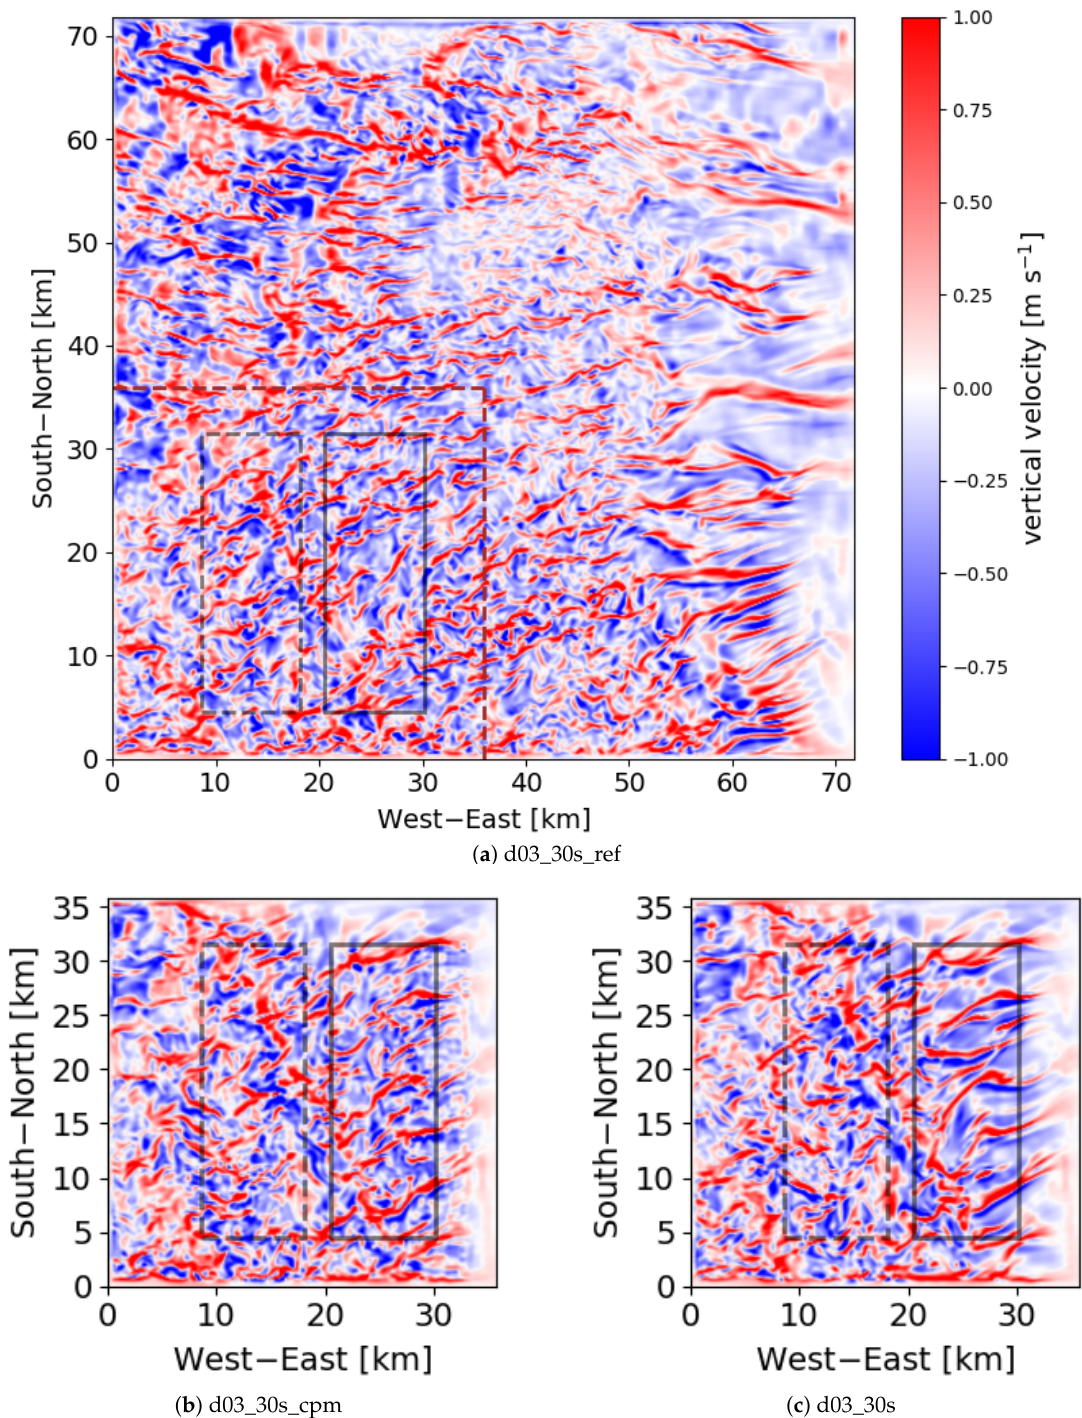
Figure 9. Contours of vertical velocity from ∼ 200 m a.g.l., the 7th model level of d03_30s, d03_30s_cpm, and d03_30s_ref at 1715 UTC 20 May 2017. Dashed brown lines in ( a ) demarcate the locations of the boundaries of the smaller LES, whose results are shown in ( b , c ). Solid black and dashed black outlined subregions are used for computing power spectra in Figure